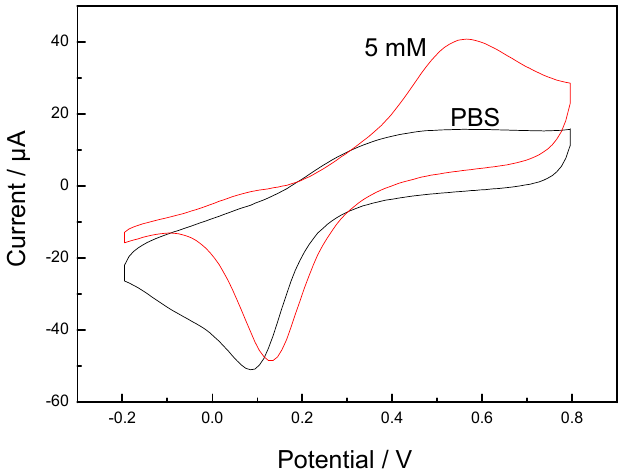
Figure 5. CVs recorded GOx / HTNTs / Ti electrode in PBS (0.01 M, pH = 7.4) in the absence and presence of 5 mM glucose at a scan rate of 10 mV s − 1 .